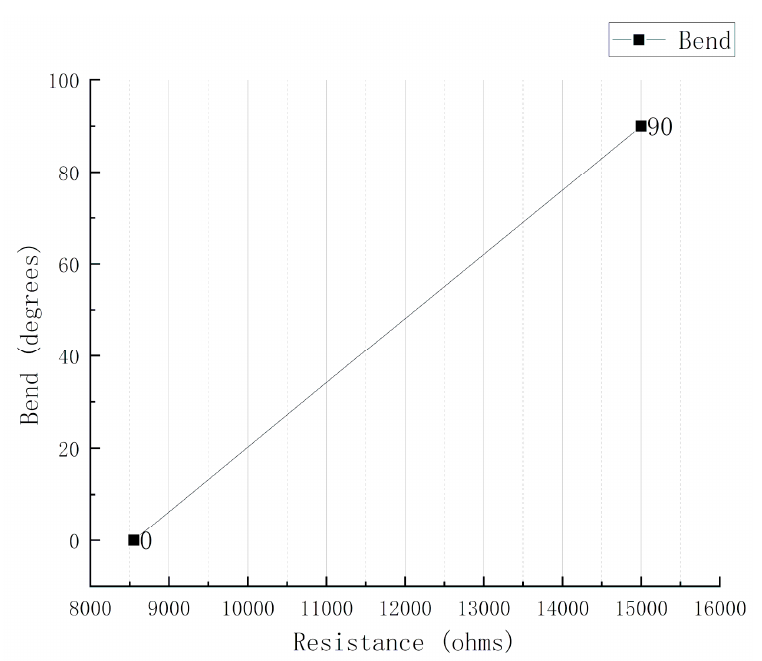
Figure 8. The calibration and fitting of the bending sensor.